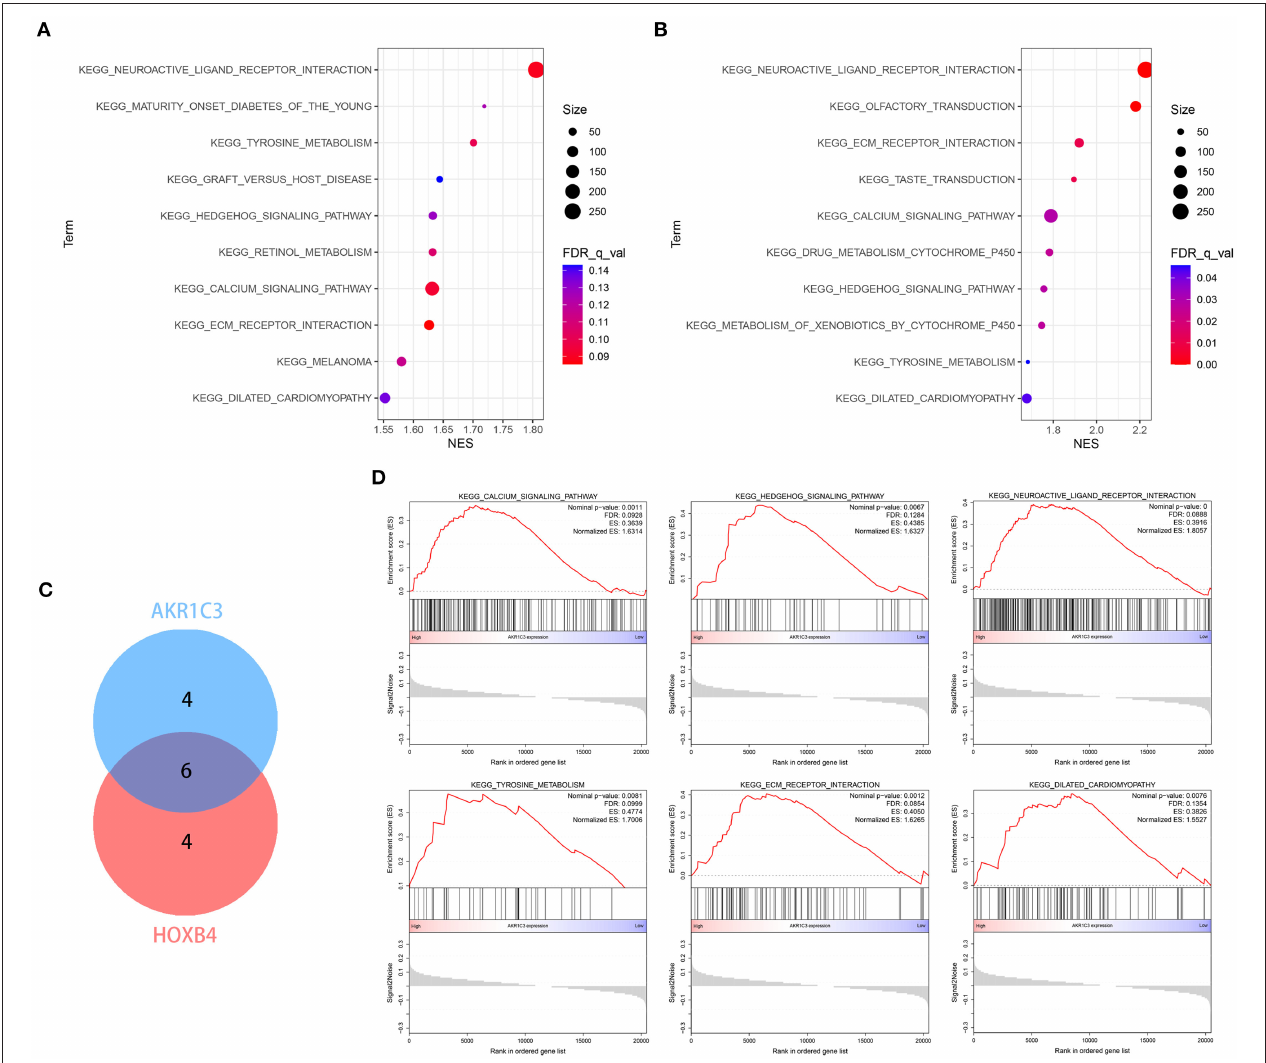
FIGURE 10 | The enrichment analysis via GSEA. (A,B) The top 10 related pathways for AKR1C3 (A) and HOXB4 (B) . (C) Venn plot indicating six overlapped pathways. (D) The overlapped pathways were mostly correlated with cardiovascular diseases. GSEA, gene set enrichment analysis.